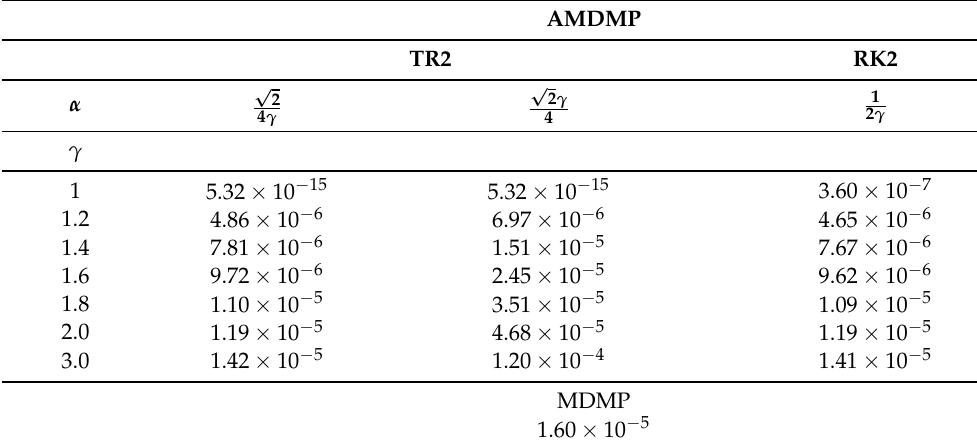
Table 1. Error in the angular momentum for the methods in the MDMP family.